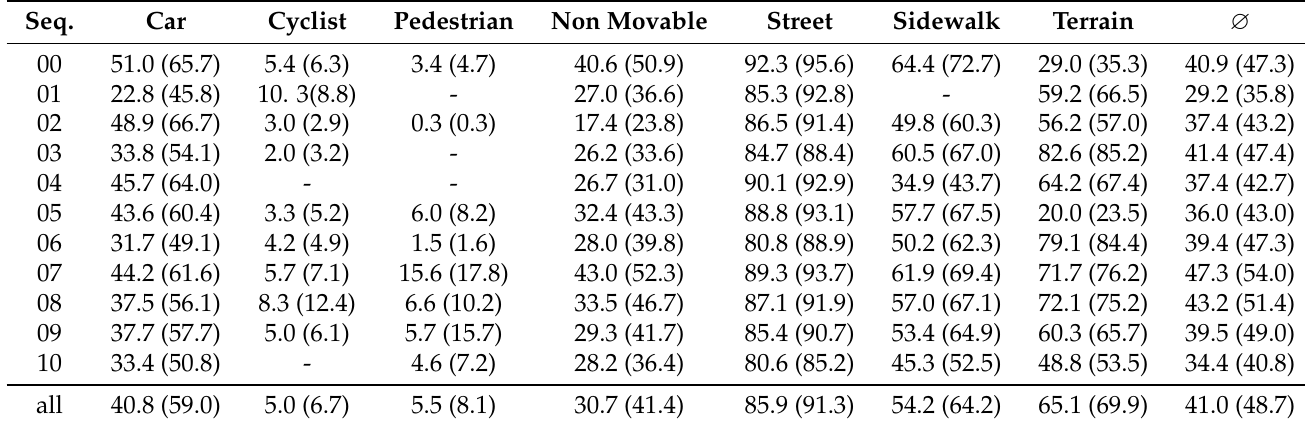
Table 1. Class IoUs IoU ω (IoU (cid:48) ω ) for the stereo vision pipeline in %. The dash indicates that there are no corresponding objects in the sequence. The column on the right contains the mean IoUs mIoU (mIoU (cid:48) ).